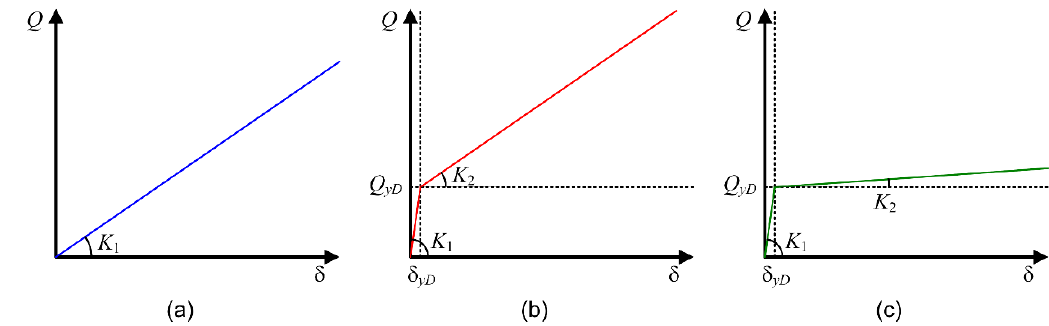
Figure 3. Envelopes of the force – deformation relationship for isolators and damper: ( a ) natural rubber bearing (NRB), ( b ) lead-rubber bearing (LRB), and ( c ) steel damper.